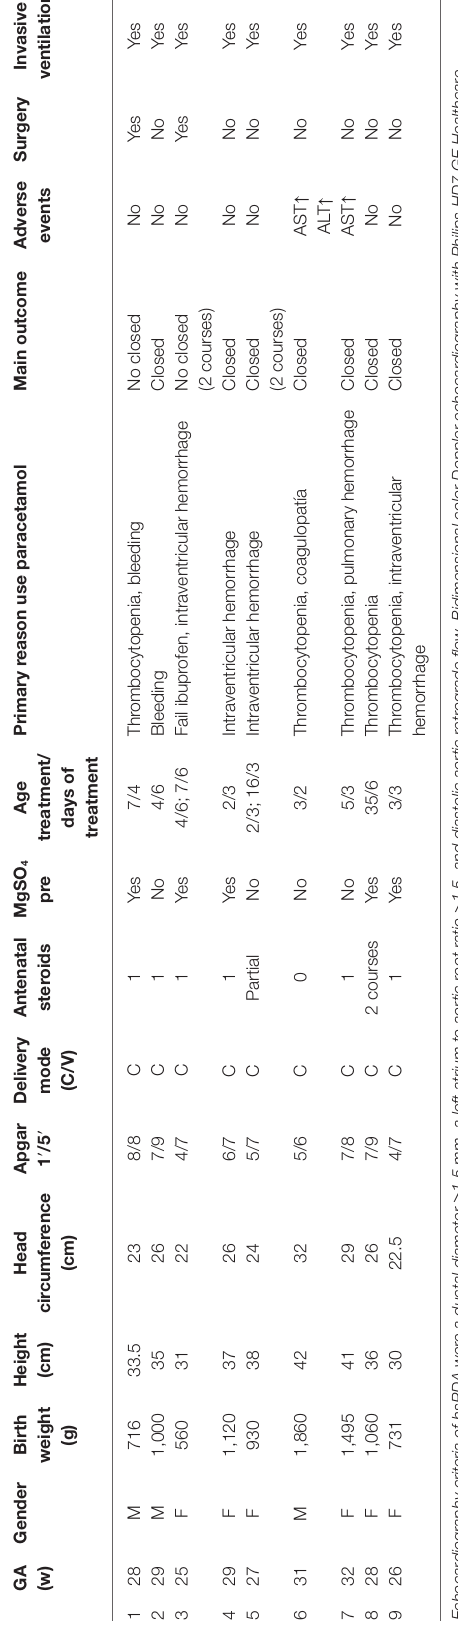
TaBle 2 | Liver tests before and 24 h after the end of paracetamol